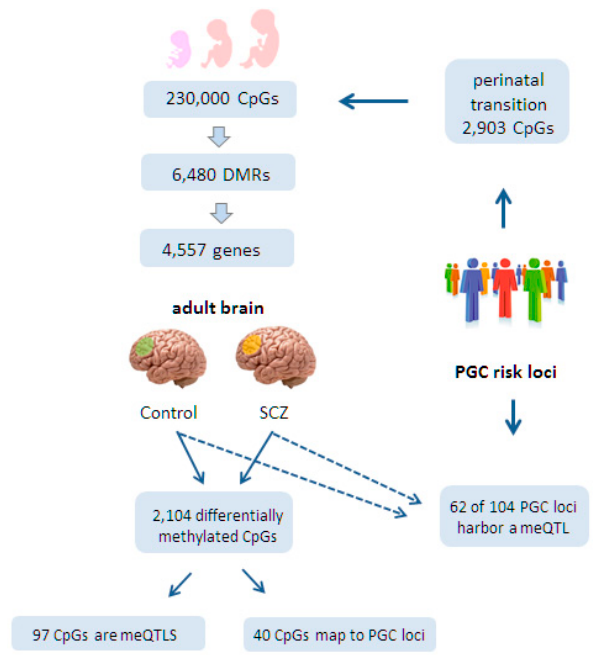
Figure 3. CpG methylation and meQTLs in fetal and adult brains from controls and people diagnosed with schizophrenia (SCZ). Jaffe et al. [126] assessed 230,000 CpGs during fetal development. Among these, they identified 6480 differentially methylated regions (DMRs) during the transition from the second fetal trimester to postnatal life. These DMRs mapped to 4557 genes. Furthermore, the genetic risk loci for SCZ, previously identified by the Psychiatric Genetics Consortium (PGC), contained 2903 CpGs that were differentially methylated during the perinatal transition phase. In an independent study on adult brains, 2104 CpGs were differentially methylated between controls and people diagnosed with SCZ in the dorsolateral prefrontal cortices (marked in light green and orange, respectively). Moreover, 97 CpGs corresponded to adult meQTLs but not another set of 40 CpGs that mapped to PGC loci. Interestingly though, Hannon et al. found in an independent study [125] as indicated by the dashed line that 62 out of 104 genome-wide significant PGC loci contained an adult meQTL.